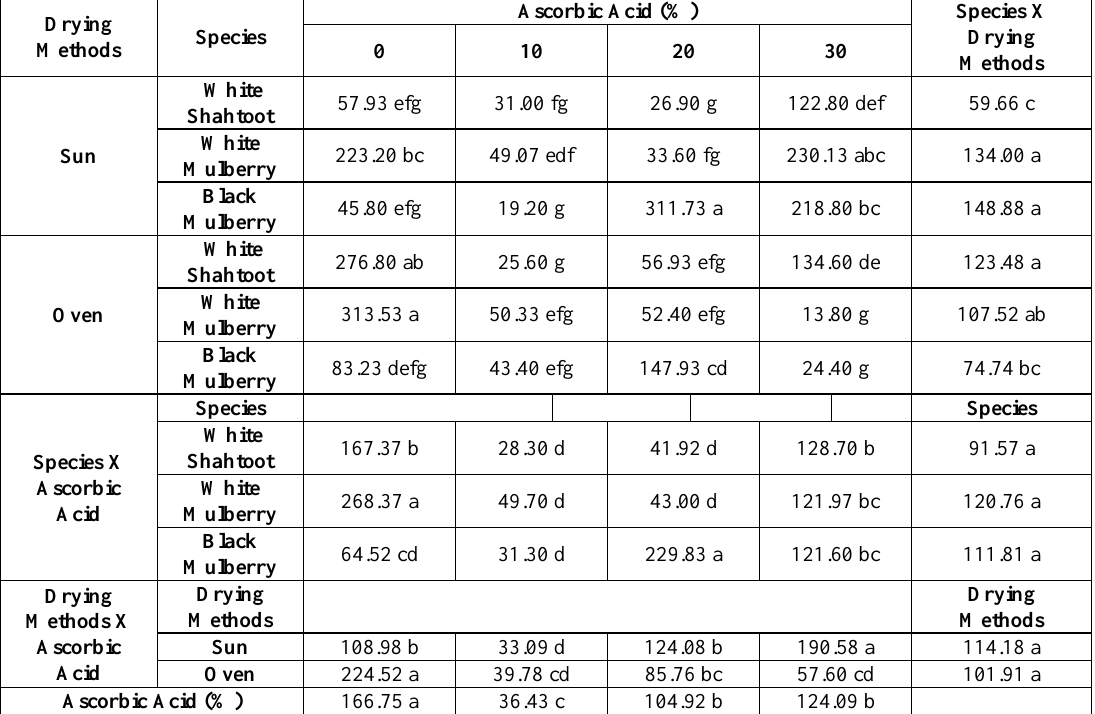
Different letters in each factor and their interactions indicate a statistical difference between treatments according to Duncan‟s multiple ranges